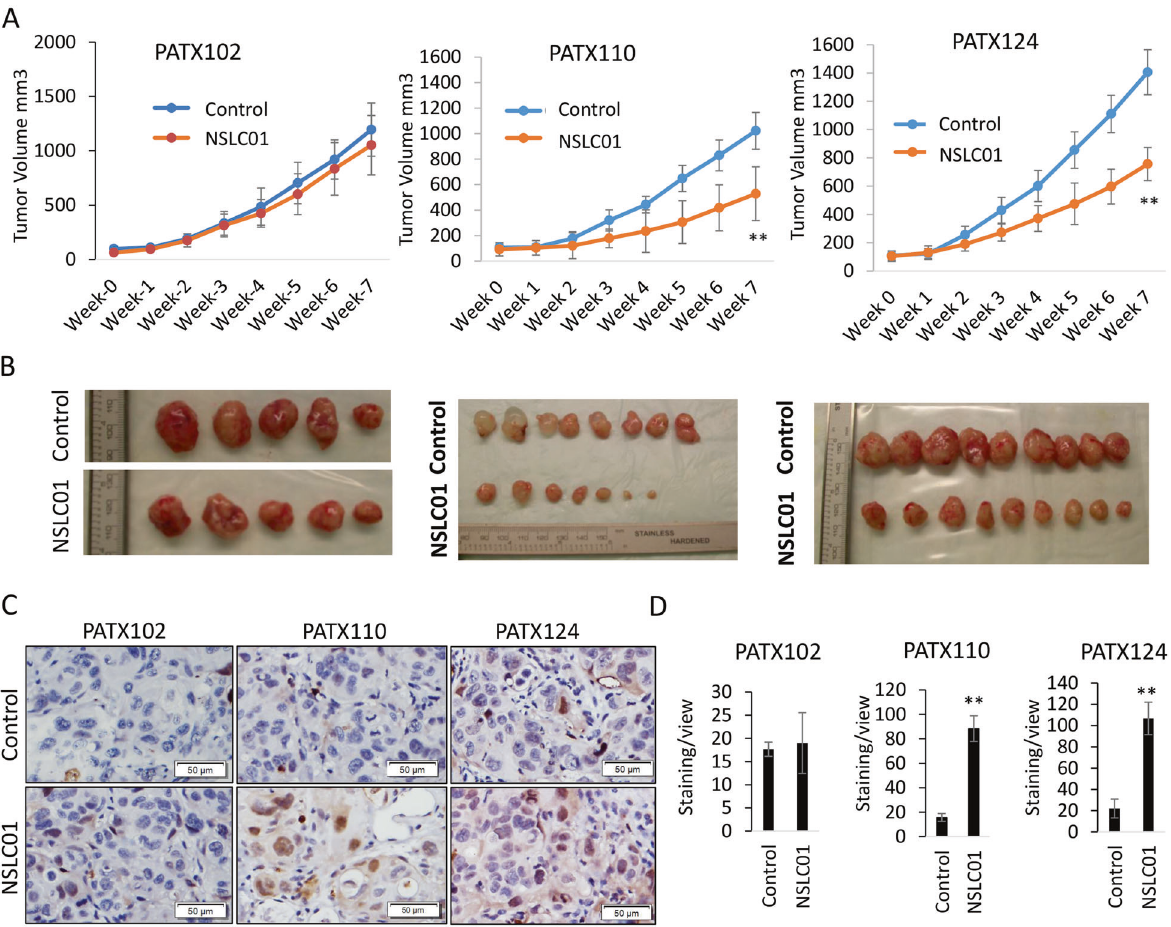
Fig. 4 NSLC01 inhibited tumor growths of NRF2-activated PDAC PDX models in vivo. A Tumor growth of PATX102 (resistant), PATX110 (sensitive), and PATX124 (sensitive). PDXs models were established in nude mice, and when tumors reached the sizes of ~100 mm 3 , mice (5 – 8 mice per group) were treated with vehicle control or NSCL01 (50 mg/kg) for 6 weeks. B Gross tumors from control and NSCL01-treated groups. C Immunohistochemistry staining of cleaved caspase-3 in tumor specimens after treatment. D Quantitation of cleaved capase-3